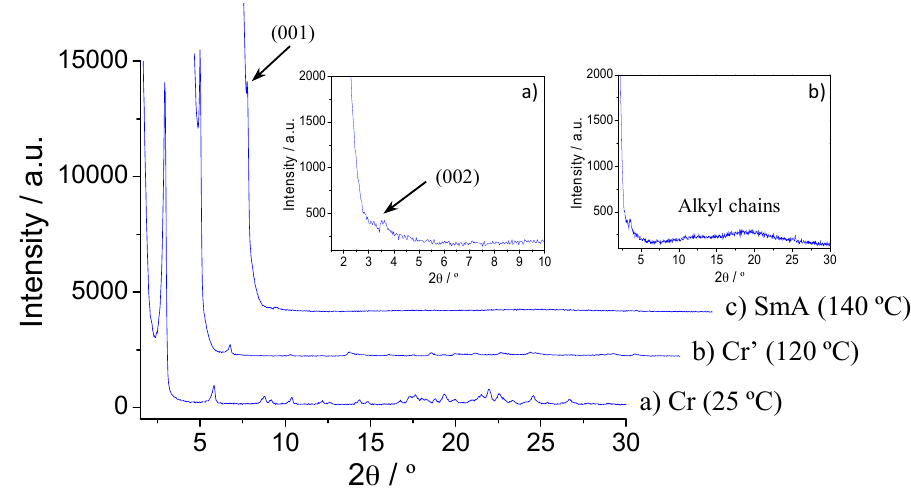
Figure 4. X-ray diffractograms of ReO 4 -16 ( 7 ) at ( a ) 25 °C; ( b ) 120 °C and ( c ) 140 °C on heating. The insets show a magnification of the XRD trace at the mesophase temperature ( a ) showing the (002) peak and ( b ) the broad halo corresponding to the liquid-like order of the molten alkyl chains.